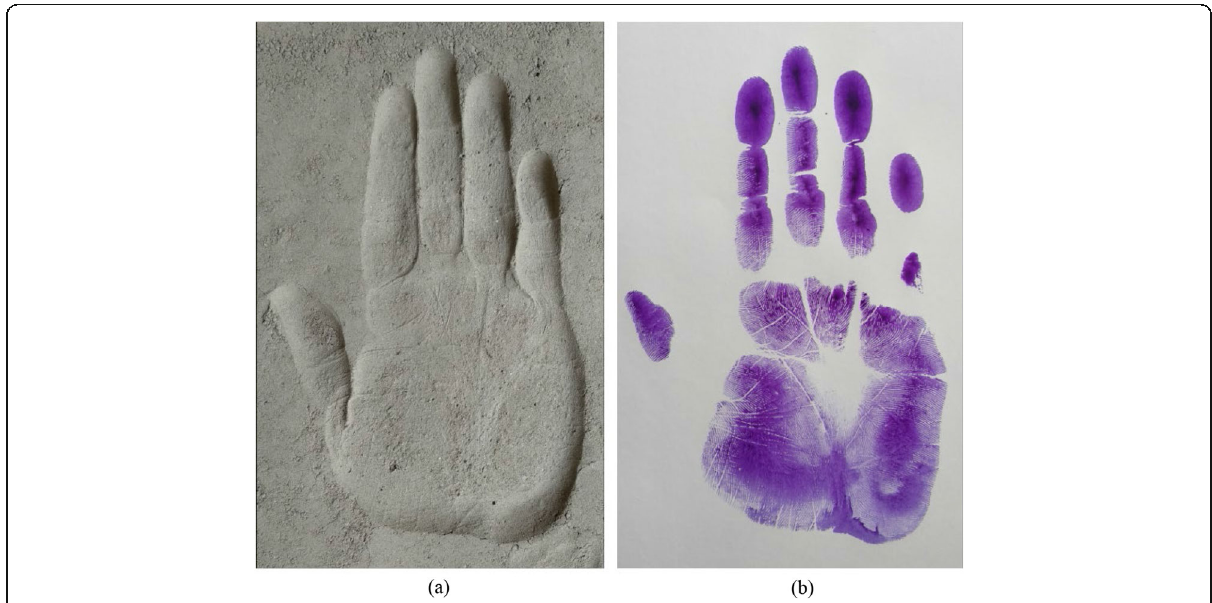
Fig. 6 a Handprint on soil. b Handprint on flat